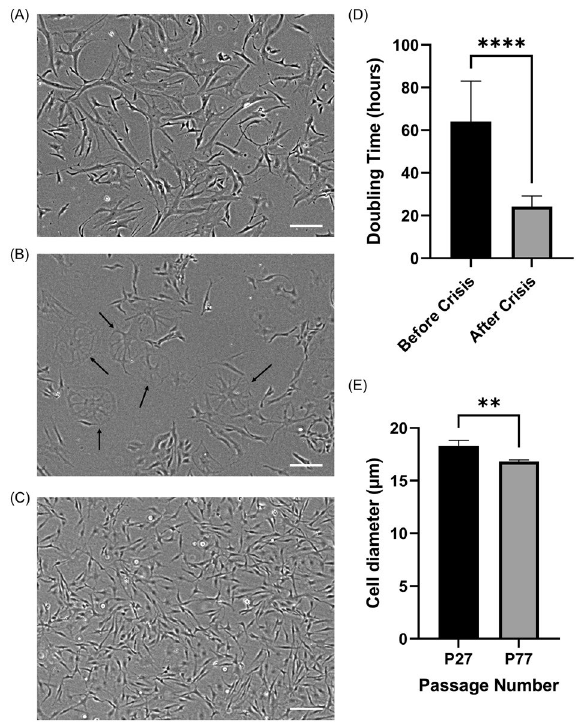
Figure 2. Spontaneous immortalization crisis event of Mack1 cells. ( A – C ) The progression of Mack1 cells through phase contrast imaging. Scale bars 200 μm. ( A ) Passage number 15, ( B ) passage number 42, ( C ) passage Number 84. Arrows in ( B ) indicate cells in crisis, as morphology is indicative of senescence. ( D ) Doubling time comparison between cells before crisis (passage numbers 12–26) and after crisis (passage numbers 114–128). Error bars indicate standard deviation, n = 15 distinct samples; statistical significance calculated by unpaired t-test and indicated by asterisks, in which p < 0.0001 (****). ( E ) Cell diameter comparison between cells before crisis (passage number 27) and after crisis (passage number 77). Error bars indicate standard deviation, n = 3 distinct samples; statistical significance calculated by unpaired t-test and indicated by asterisks, in which p < 0.01